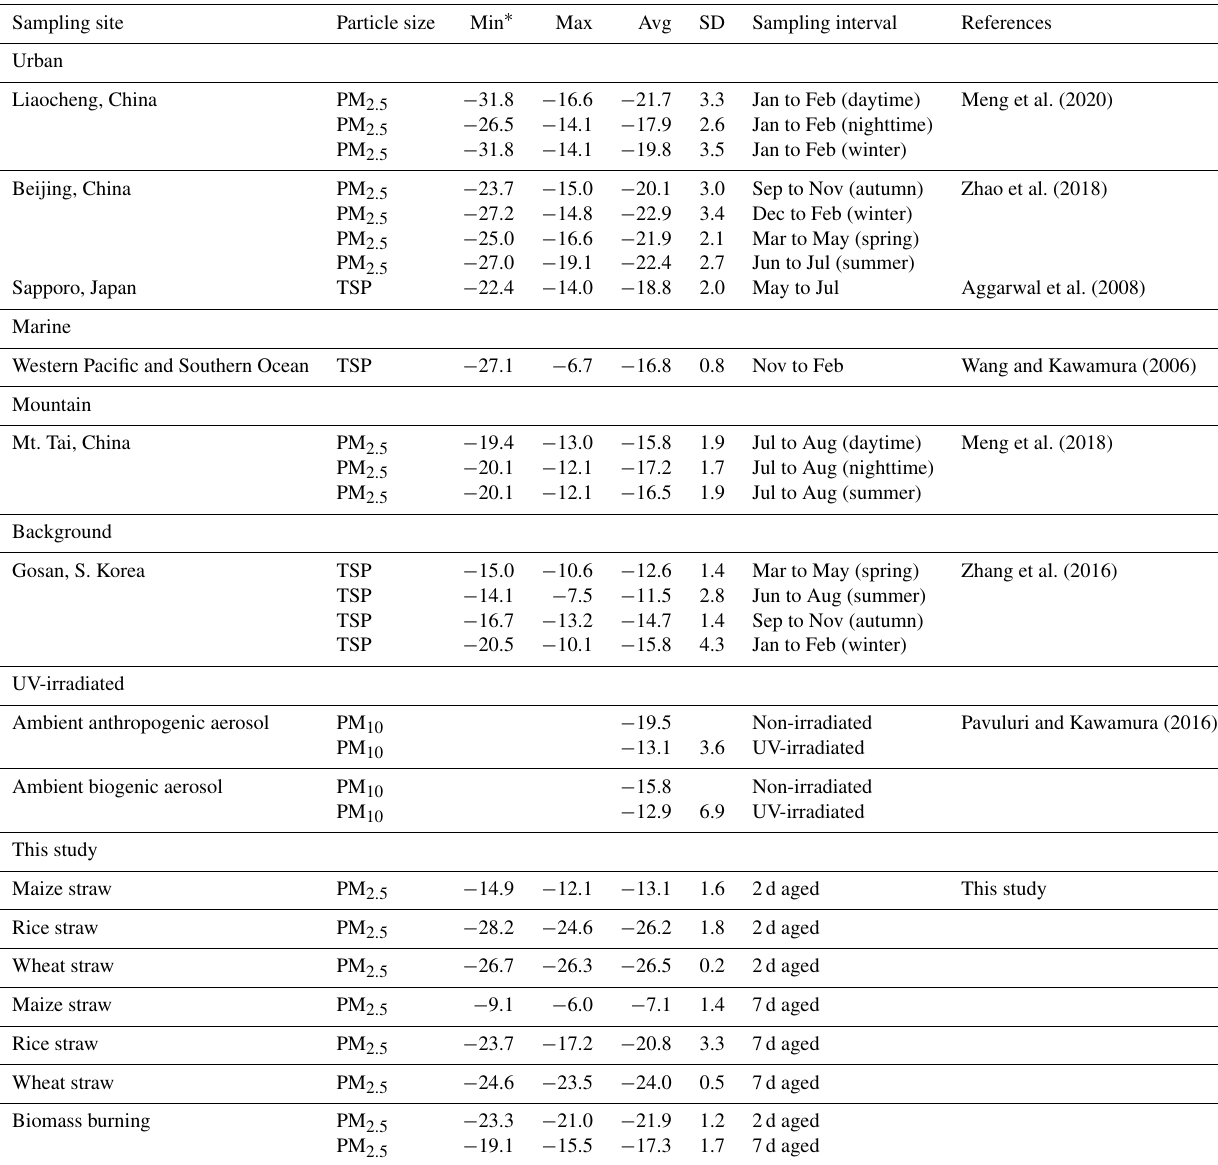
Table 3. Stable carbon isotope ratios ( δ 13 C, ‰) of C 2 in atmospheric aerosols from selected locations. Sampling